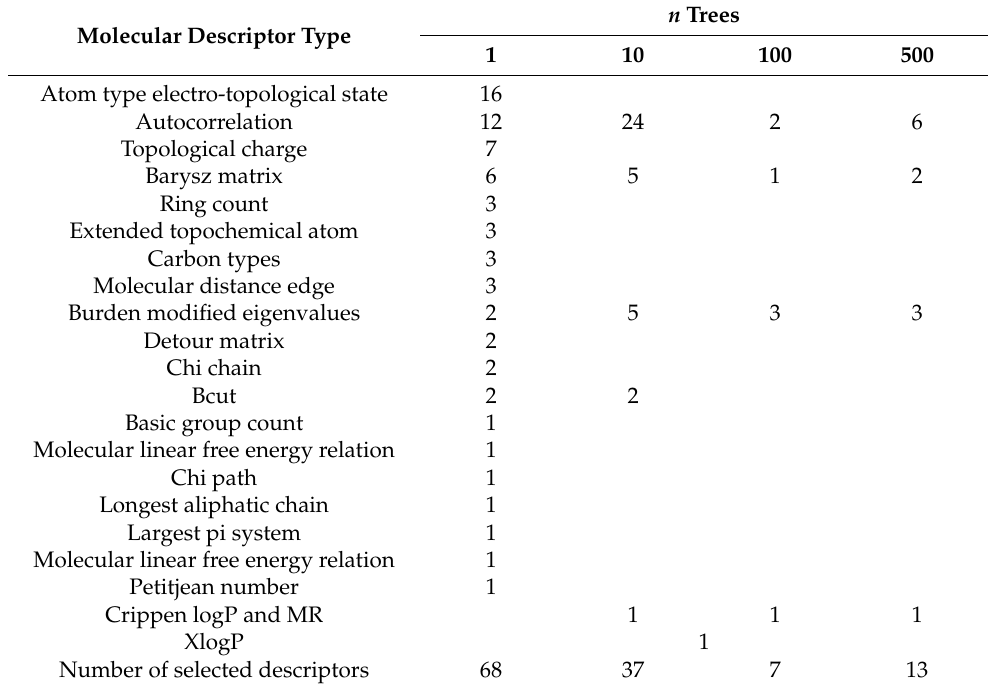
Table 1. Molecular descriptors